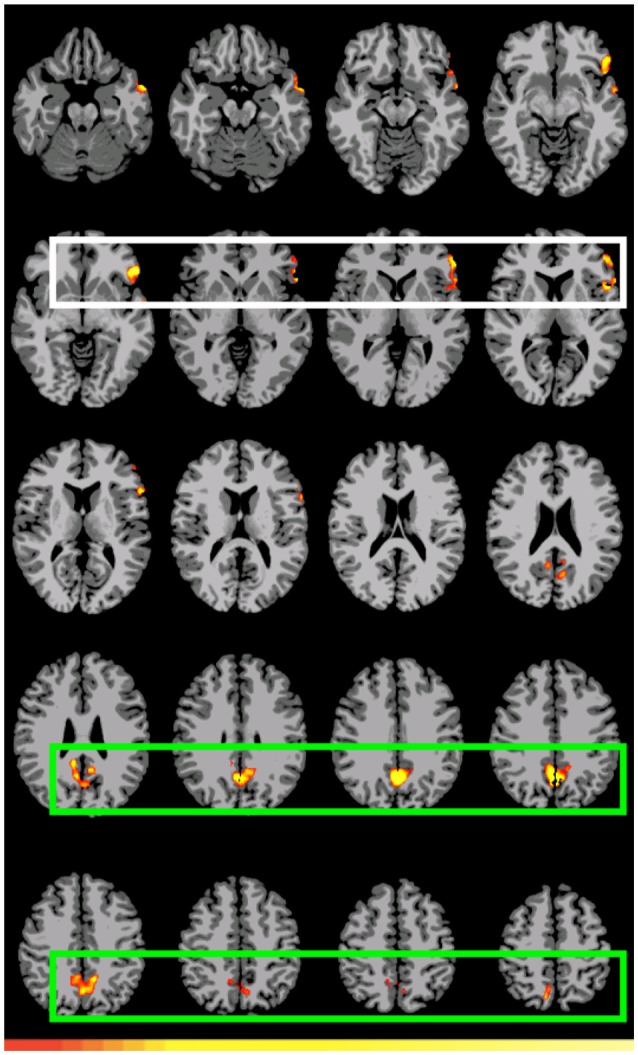
Preferential activation for (direct) GAP-search (Event 1) double subtraction: (A1>D1) vs. (A2>D2). White: BAs 44, 45, 46, and 47. Green: Posterior cingulate and sensory association cortex. Images are shown corrected at p < 0.05 in radiological format (LH is on the right). Only positive activation reported. Low thresholds (p < 0.05; t = 2.14) are indicated by red, while high thresholds (p < 0.000005; t = 7.20) are indicated by yellow.